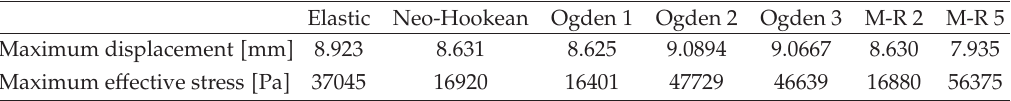
Table 4: Comparison of maximum displacement and e ff ective stress using seven brain models for a frontal pressure boundary condition without